Question: In one sentence, what is this figure communicating?
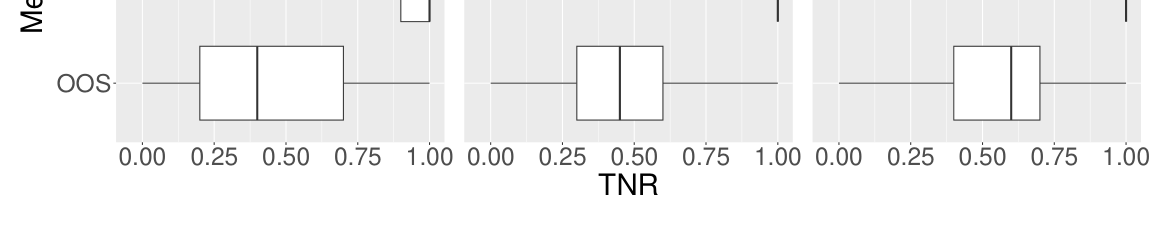
Answer: Simulation 2: boxplots for TNR (the true negative rate for the input variables) for the models selected by each objective function.